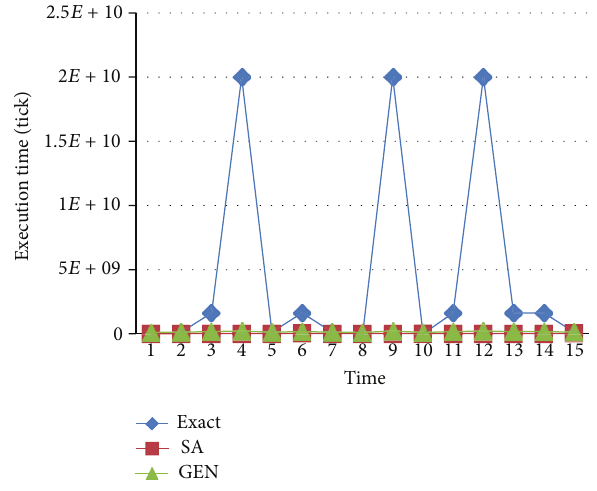
Figure15:Number Object/ 𝑇 50) , and simulated annealing ( fact = 0.8)